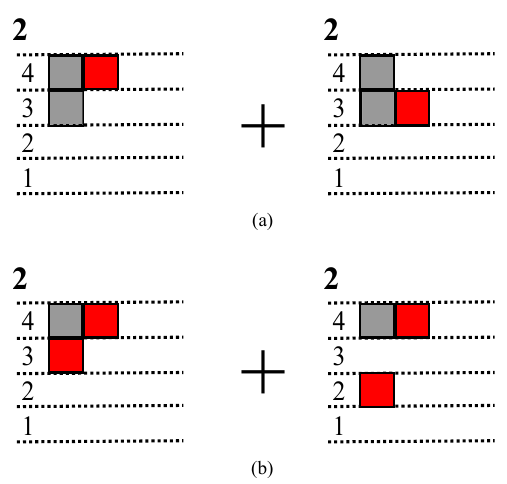
Figure 2 . Tableaux indicating the permutations of the red tiles among the